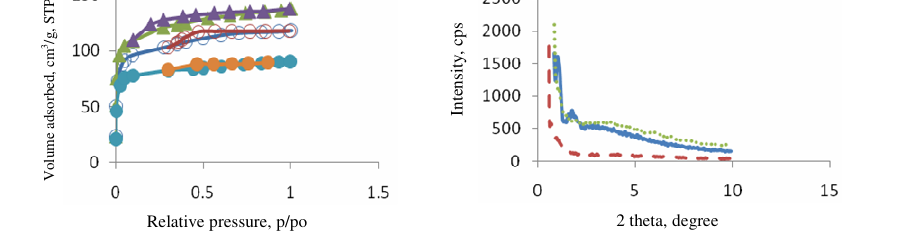
Figure 3. N Figure 4. Low angle XRD pattern of 2 adsorption-desorption 2 isotherms of samples 2 (open circles, (dash line), 3 (solid line) and 4 (dot) with different molar ratio